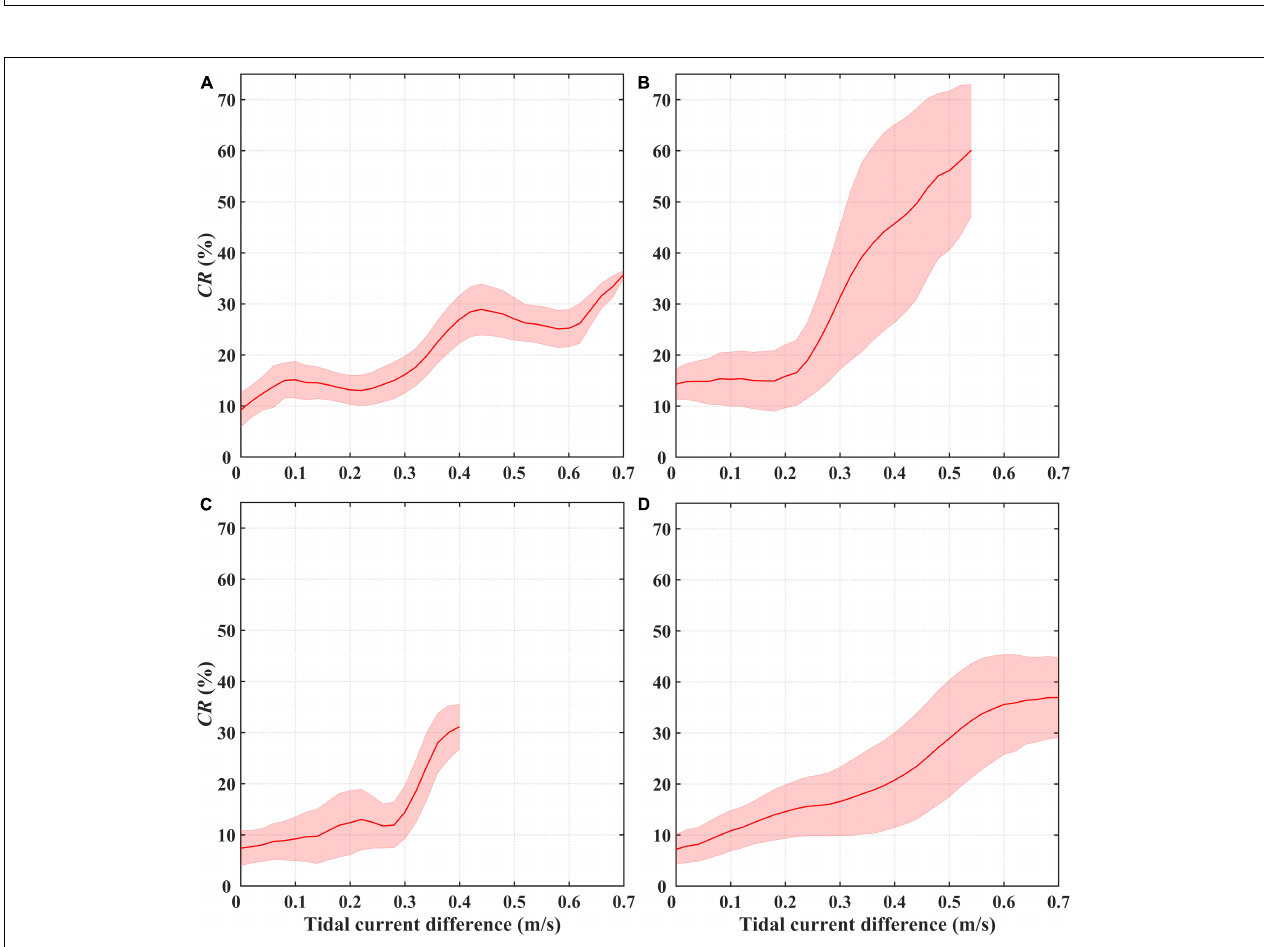
FIGURE 9 | Spring-neap tidal current difference maximum vs. Chl- a contribution rate ( CR ) induced by the spring-neap tide in areas (A–D) . The red curve represents the average and the pink shading indicates the error derived from the standard deviation.